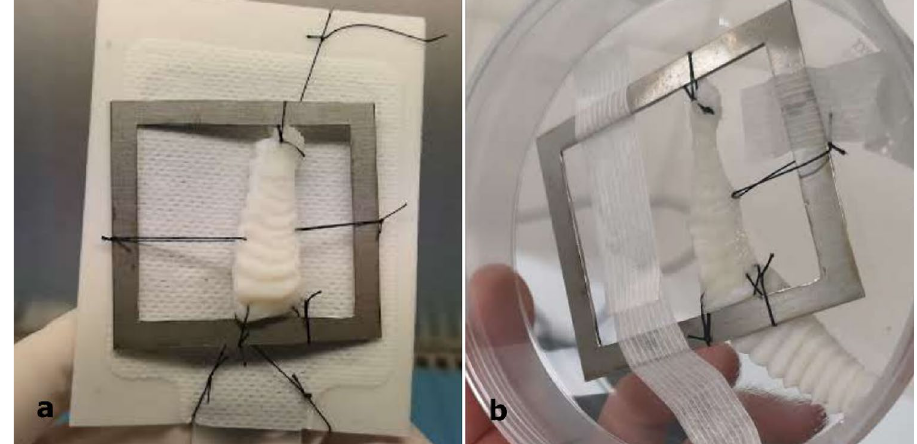
Figure 2. ( a , b ) Representative images of ( a ) non-pored and ( b ) pored scaffolds. Half of the decellularized scaffolds was treated with a microscopic patented perforative treatment using a Quantum Molecular Resonance current generator (VESALIUS) connected to a 300 μm-diameter needle, generating up to 1000 micropores/ cm 2 . The macroscopic examination showed a slightly increased stiffness and a decreased thickness in the pored samples, which also showed a more transparent appearance compared to the non-pored ones.